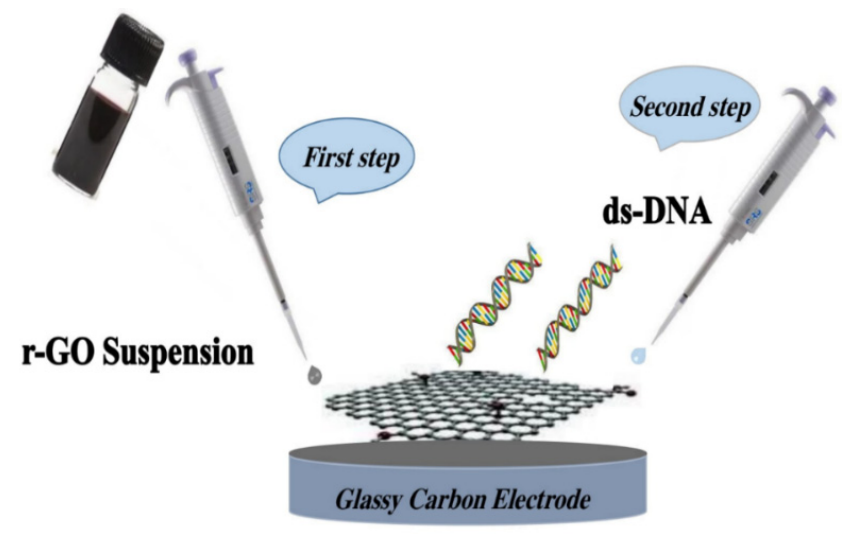
Table 1. Physical measurements and instrumentation